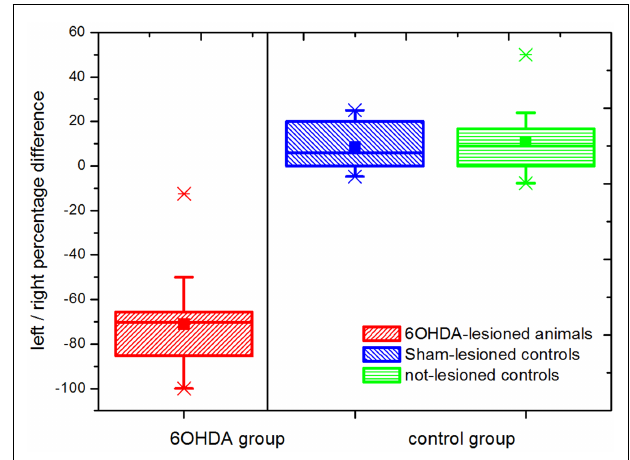
FIGURE 1 | Cylinder test results . Percentage differences in weight supporting wall touches with the left (negative) vs. right (positive) paw are shown. Statistically significant differences were observed between the parkinsonian model ( n = 16) and both the Sham-lesioned ( n = 10) and the not-lesioned ( n = 10) control groups ( p ≤ 0.05).This not-overlapping behavioral differences between parkinsonian (6OHDA-lesioned) animals and both control groups follow the correct implementation of the model.The boxes edges represent percentile 75 (p75) and percentile 25 (p25), respectively, the inner line indicates the median and whiskers account for p75 + 1.5 (p75–p25) and p25–p1.5 (p75–p25) respectively.The mean is represented by the inner, solid box. Crosses indicate